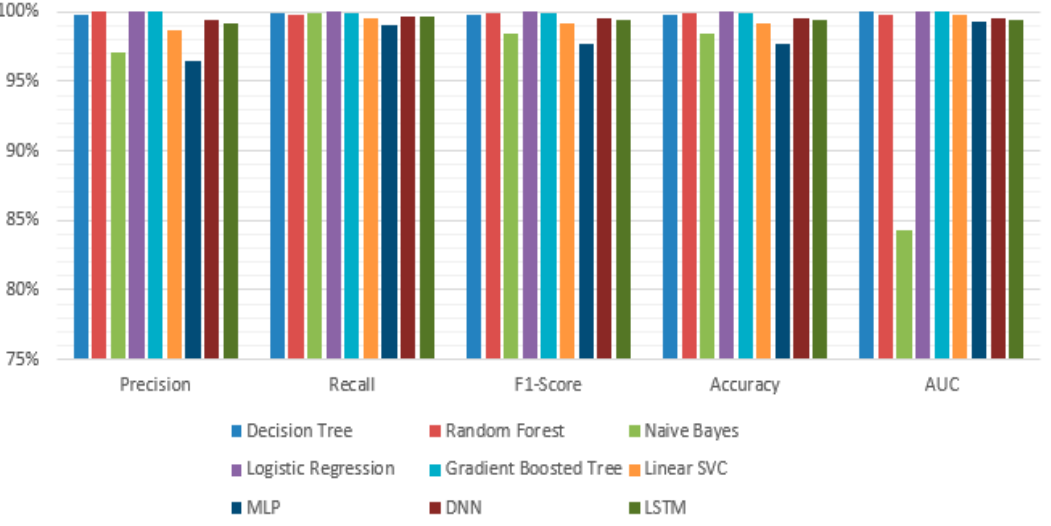
Figure 9. Performance Comparison of ML and DL Models.